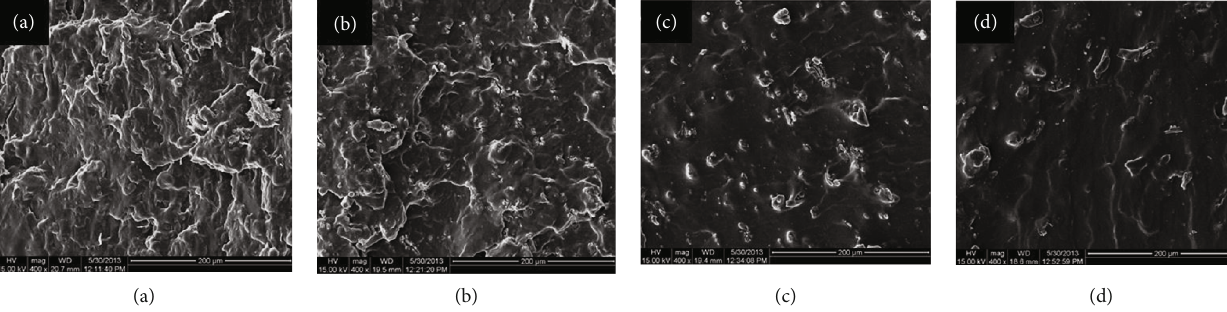
Figure 5: SEM micrographs of the fracture surface of OWPF/TPS composites with di ff erent oxidation degrees: (a) 0.125 OWPF/TPS; (b) 0.25 OWPF/TPS; (c) 0.375 OWPF/TPS; (d) 0.5 OWPF/TPS.